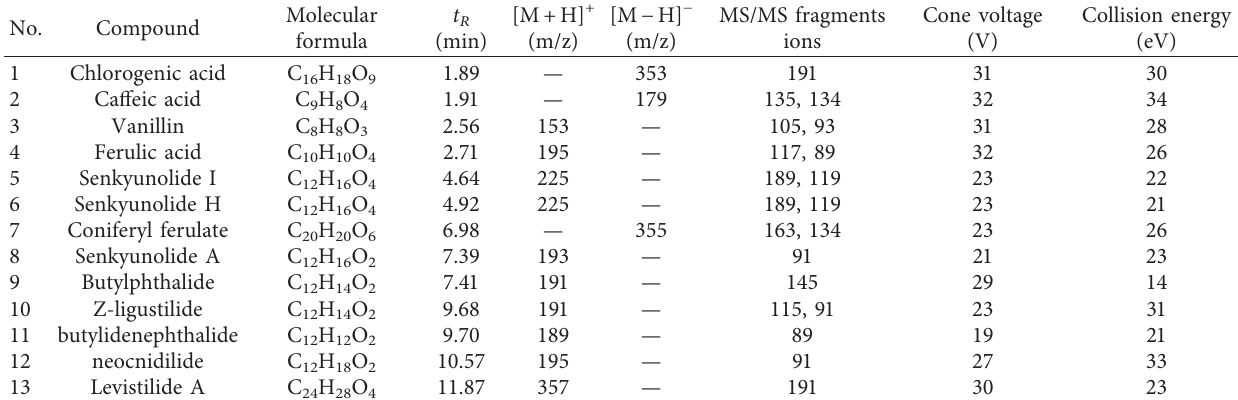
Table 1: UHPLC-MS/MS parameters for MRM of compounds of sample.